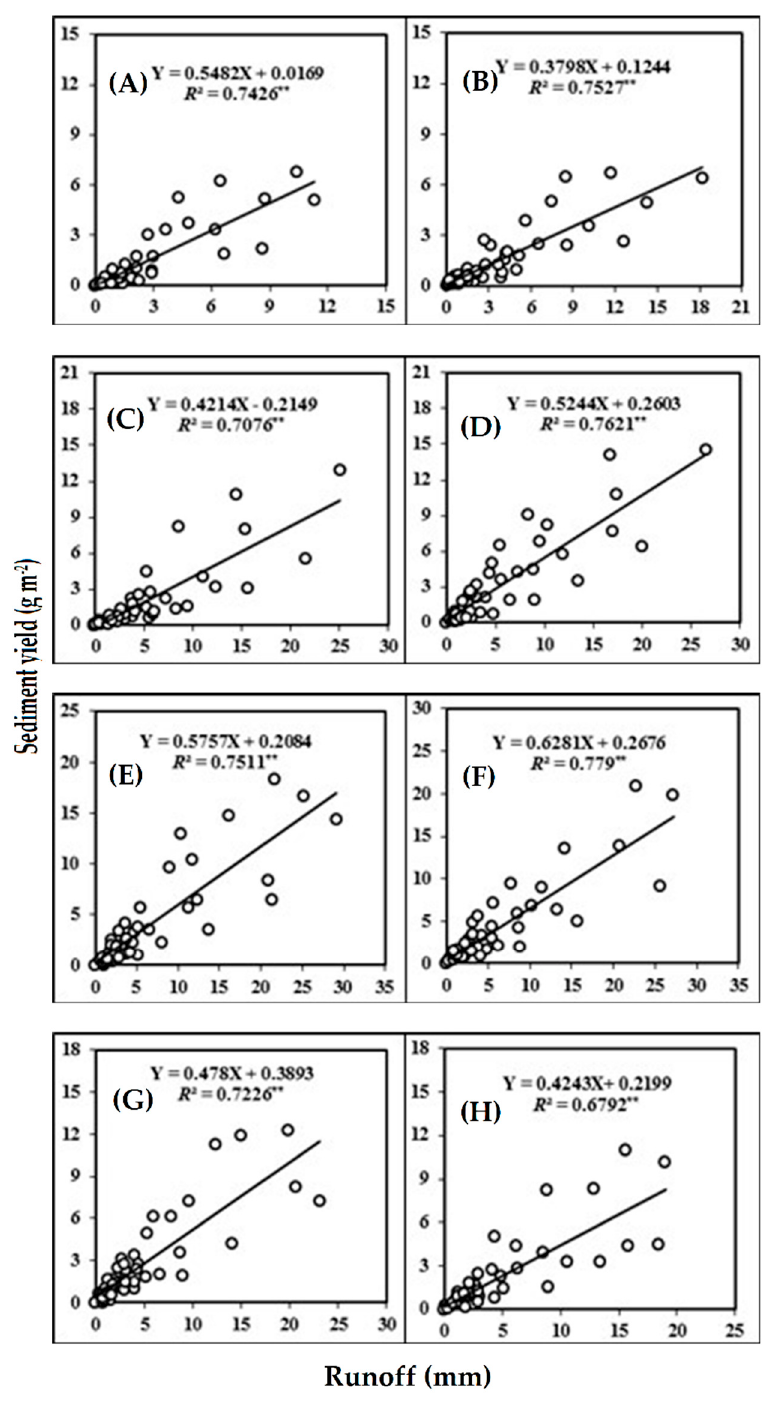
Figure 3. Relationship between runoff versus sediment yield on plot with different slope gradients ( A ) 5%, ( B ) 10%, ( C ) 15%, ( D ) 20%, ( E ) 25%, ( F ) 30%, ( G ) 35% and ( H ) 40%. For each graph, the regression equation and the coefficient of determination ( R 2 ) are given. Note: ** P < 0.01. In each value of precipitation depth, there was a bell-shaped trend between runoff, runoff coefficient, and sediment yield and slope; initially there was an increase with slope gradient, and then a decrease after a critical slope gradient, indicating that greater values of runoff, runoff coefficient, and sediment yield were found at the slope gradient of 25% (Figure 4).